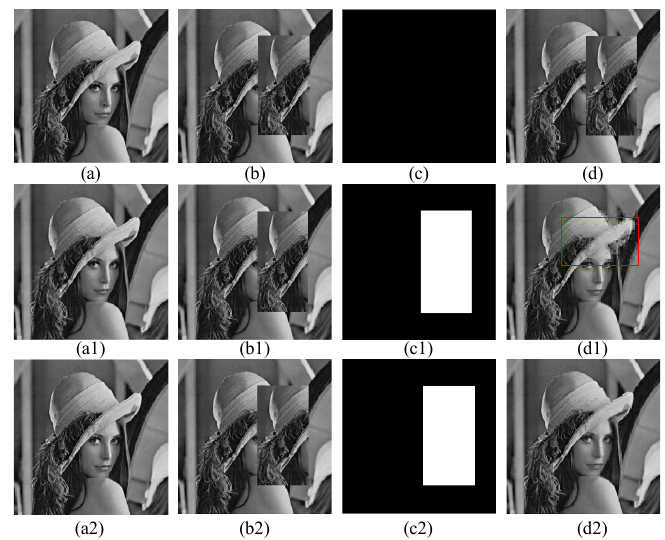
Figure 11. Collage attack simulation of first kind: ( a ) Lee [1] watermarked image ( PSNR = 40.72 dB); ( b ) Lee tampered image; ( c ) Lee tamper detective image; ( d ) Lee recovered image ( PSNR = 17.26 dB); ( a1 ) Tai [5] watermarked image ( PSNR = 44.01 dB); ( b1 ) Tai tampered image; ( c1 ) Tai tamper detective image; ( d1 ) Tai recovered image ( PSNR = 29.21 dB); ( a2 ) Proposed watermarked image ( PSNR = 40.72 dB); ( b2 ) proposed tampered image; ( c2 ) proposed tamper detective image; and ( d2 )